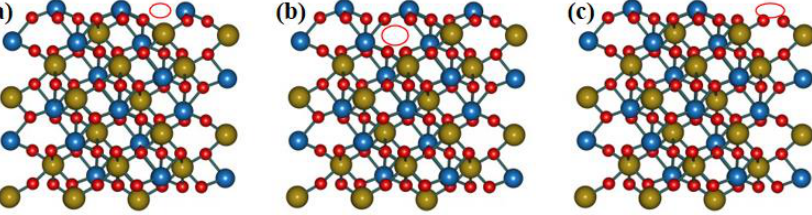
Figure 7. Structures of O defect ( a ), Sn defect ( b ), Zn defect ( c ) on 001 surface of ZS. The defect locations are marked with red circles.